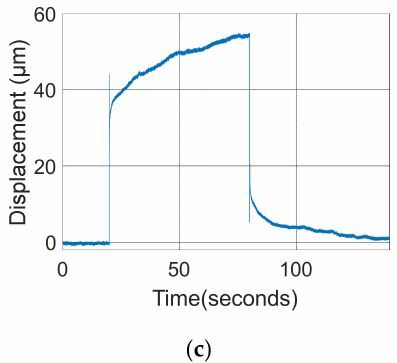
Figure 3. ( a ) Comparison of the open-loop experiment data with the identified model; ( b ) Close-up view of ( a ) for the first 100 ms; and, ( c ) Creep phenomenon when DEA is actuated for long time spans, 70 s ON and 70 s OFF.